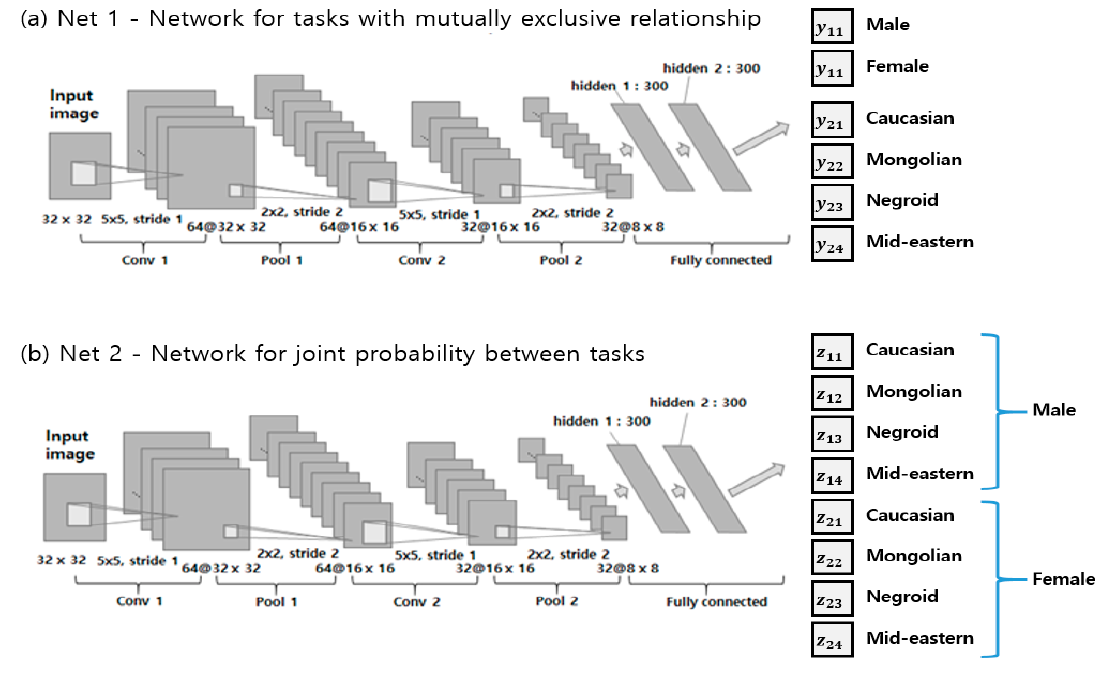
Figure 4. Overview of network structure for multi-attribute recognition with two tasks: ( a ) Net 1—Network for tasks with a mutually exclusive relationship, ( b ) Net 2—Network for the joint probability between tasks.